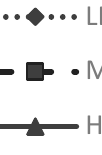
Figure 3. Body condition score (BCS; 1–5) of buffaloes fed a low energy (LE), medium energy (ME) or high energy (HE) level during 9 weeks prepartum. Low, medium, and high energy levels were NE L : 1.30, 1.42, and 1.53 Mcal/kg, respectively, on DM basis in dietary treatments. Values represent LS means ± SEM.